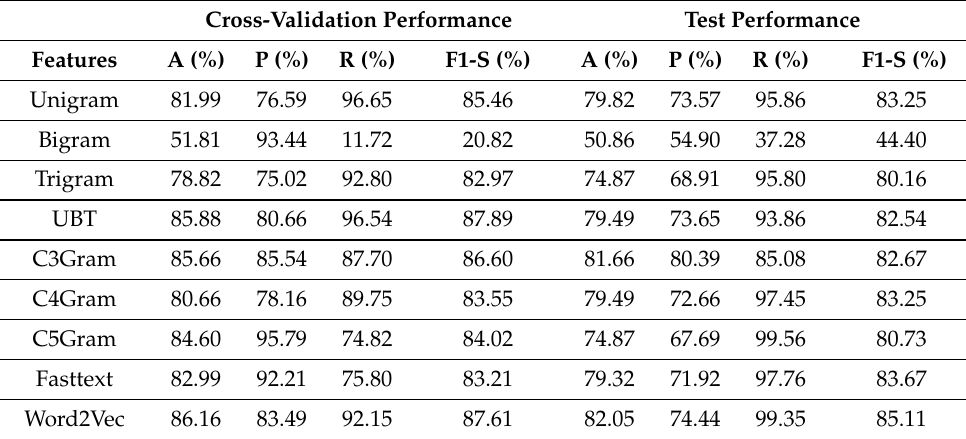
Table 5. Performance of Multinomial Naive Bayes (MNB) machine learning